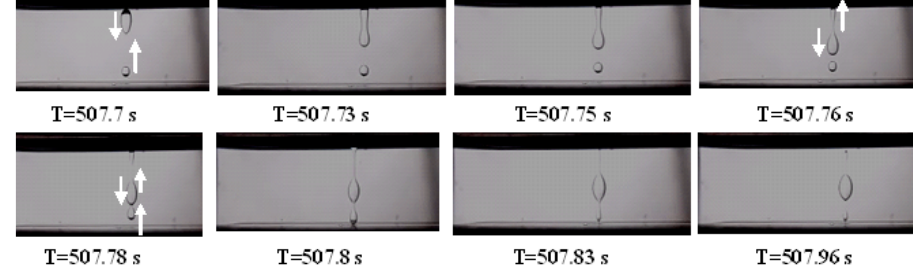
Fig. 9. Making a thread due to large elongation and increasing the voltage (Ca